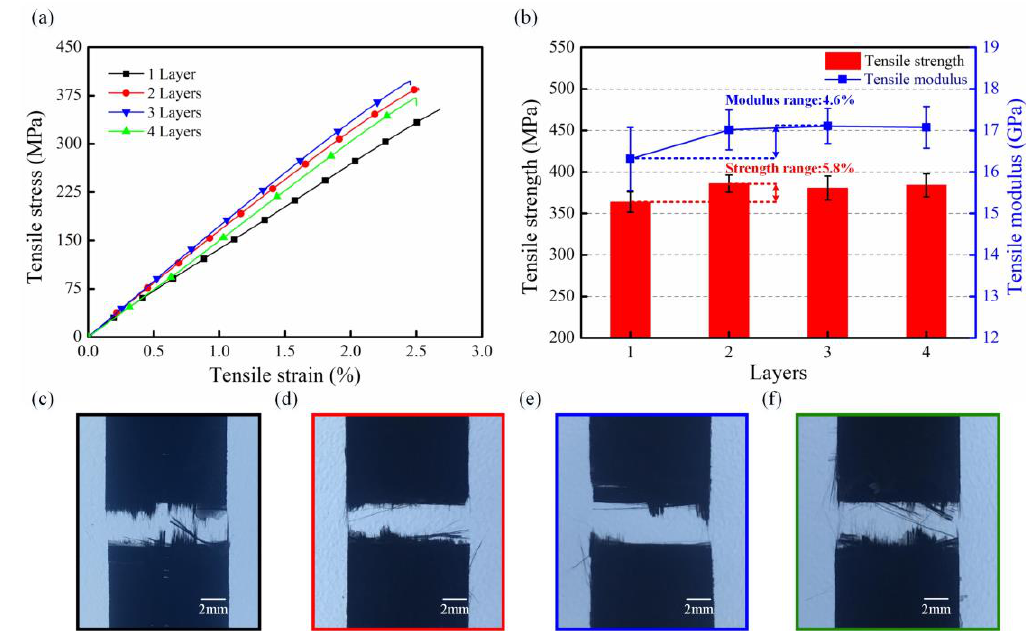
Figure 7. Tensile properties of the carbon–fabric/PC laminates with different layer numbers: ( a ) stress-strain curves; ( b ) tensile strength curves and tensile fracture morphologies; ( c – f ) are the fracture morphologies of multi-CFPLs with 1-, 2-, 3- and 4-layer unit-CFPLs, respectively.